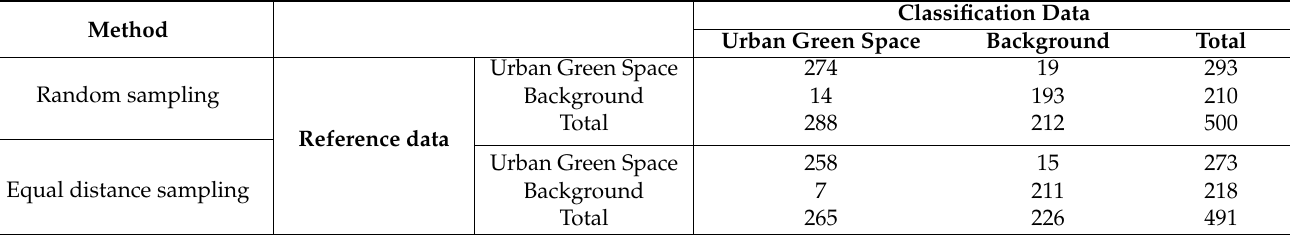
Figure 13. Comparison of different sampling methods for accuracy verification ( a ) Random sampling method; ( b ) Equal distance sampling method. Table 6. Confusion matrix for urban green space mapping.